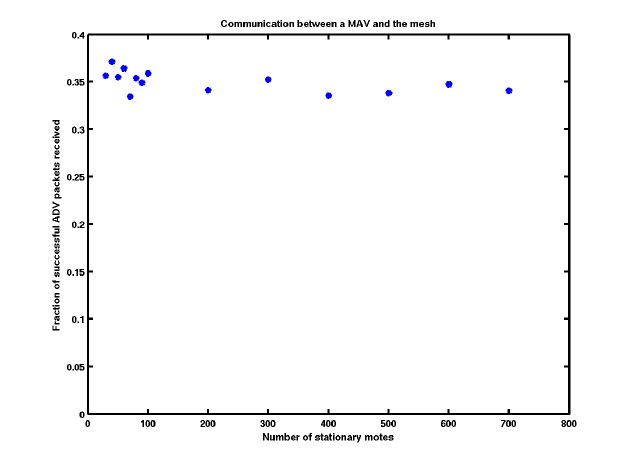
Figure 8. Regardless of the density of the underlying mesh network, the MAV successfully hears a fraction of the advertisement packets, and so can communicate during approximately 35% of the available slot